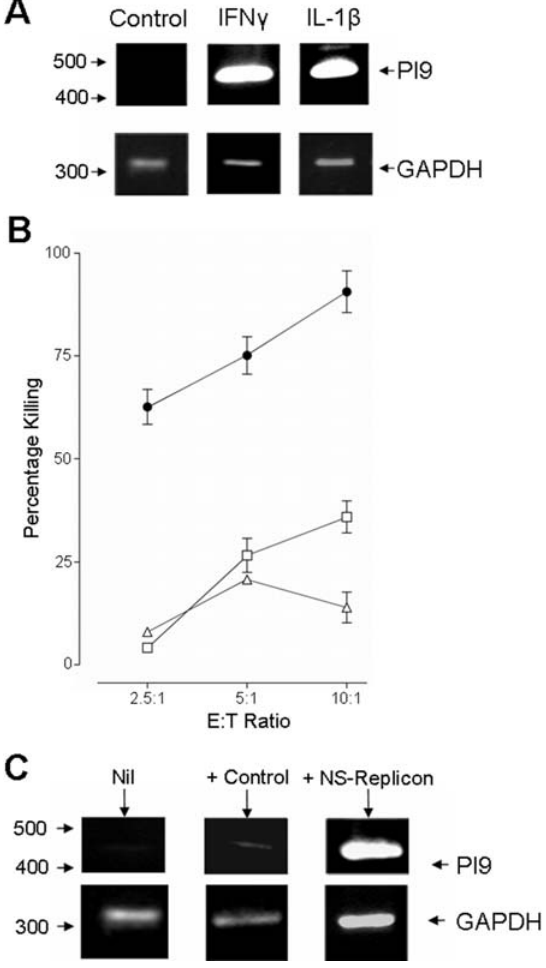
Figure 8. Analysis of alternative triggers for PI-9 expression. A ) The up-regulation of PI-9 was also found to be triggered by other inflammatory cytokines. HepG2 cells were treated for 16 hours with either IFN- c at 100 IU/ml, or IL-1 b at 50 ng/ml. GAPDH expression was used as a positive control. B ) Stimulation of the HepG2 cell line with either IFN- c (open squares) or IL-1 b (open triangles) also inhibited CTL killing compared to the un-stimulated HepG2 cells (closed circle). C ) HepG2 cells were left un-infected (Nil), or infected with either analysed by RT-PCR. PI-9 was strongly up-regulated only in the cells expressing the sub-genomic replicon. GAPDH expression was used as